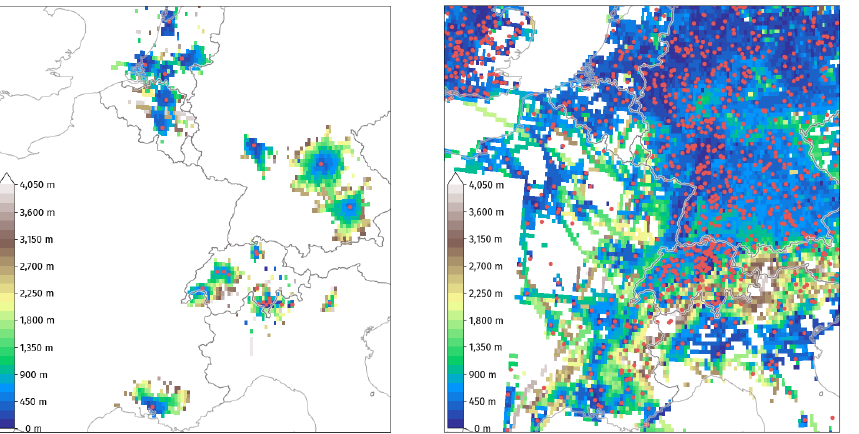
Figure 2. FLARM coverage (minimal altitude detected) for equipped aircraft. Red dots match the location of receivers feeding the OpenSky Network ( left ) and the Open Glider Network ( right